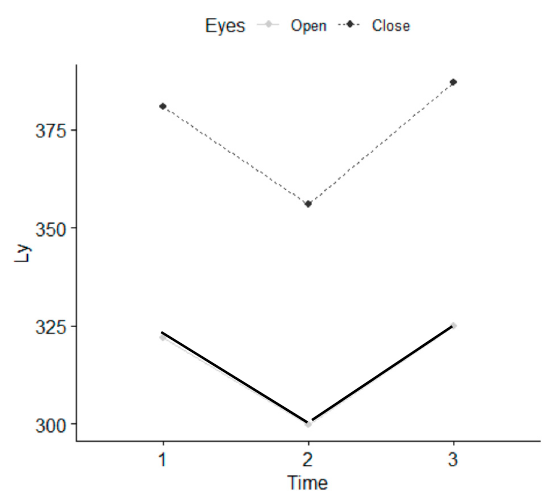
Figure 7. Length in (Ly) parameter, 1 (T0 before), 2 (T1 immediately), 3 (T2 7–10 days). The SF-36 items for the statistical analysis of bodily pain, were grouped into: “none, moderate and severe”. The pain interference item was grouped as “not at all, moderately and extremely”. Statistically significant differences were found for the two items in the population that carried out physical activity and also in the EQ-5D-3L (Table 3). Statisti- cally significant differences were found for pain in subjects that did physical activity (Ta- ble 4). Statistically significant differences were reported for the anxiety item and the visual analogue scale (EQ-VAS) (Table 5). No adverse events were observed. Table 3. Comparison between first and second post intervention with eyes open and closed. 1st Post (T1) n: 41